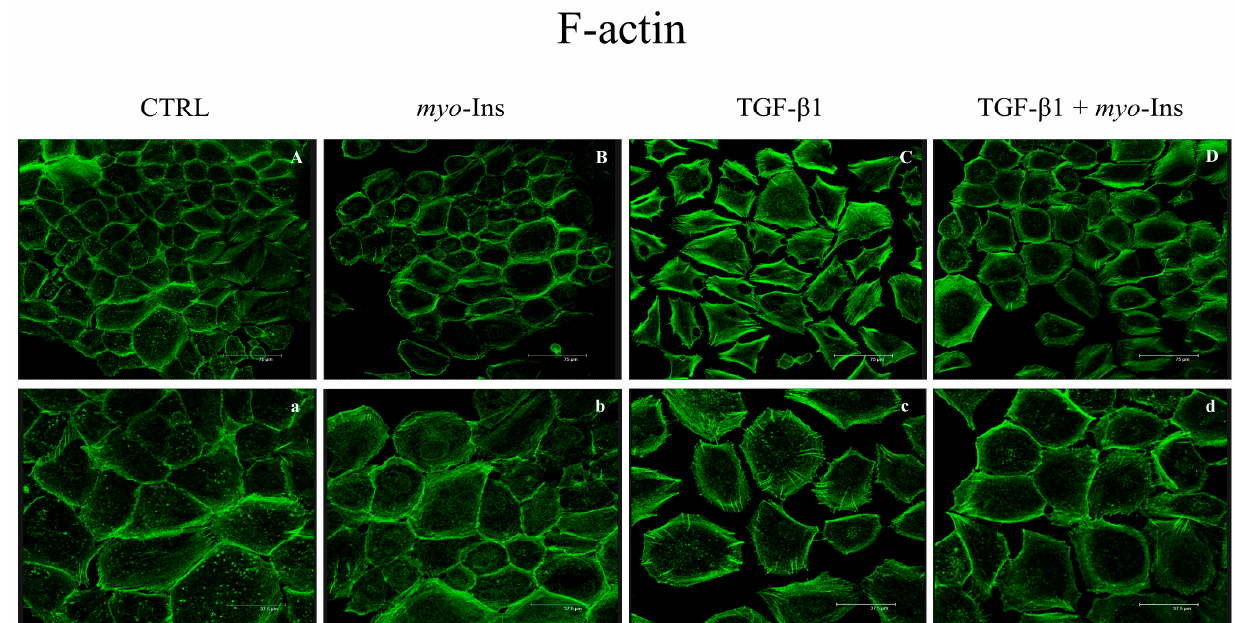
Figure 4. Myo-Ins modulates the F-actin remodeling induced by TGF- β 1 in MCF-10A cells. Immunofluorescence analysis of F-actin in MCF-10A cells treated with TGF- β 1 alone or with myo-Ins. In control cells ( A , a ) and in cells treated with myo-Ins alone ( B , b ), F-actin is organized in cortical position. Cells treated with TGF- β 1 lose the typical basal-cell polarity, showing an isotropic distribution of actin behind the membrane ( C , c ). Presence of stress fibers increases within the cytosol. Lamellipodia and invadopodia are observed at the edge of transformed cells, which appeared scattered over the area, without clear connections to each other. The addition of myo-Ins almost completely reverts F-actin changes, re-establishing cell-to-cell contact ( D , d ). Images were scanned under a 40 × objective. Scale bar of ( A – D ): 75 µm. ( a – d ) are a magnification of the same images.